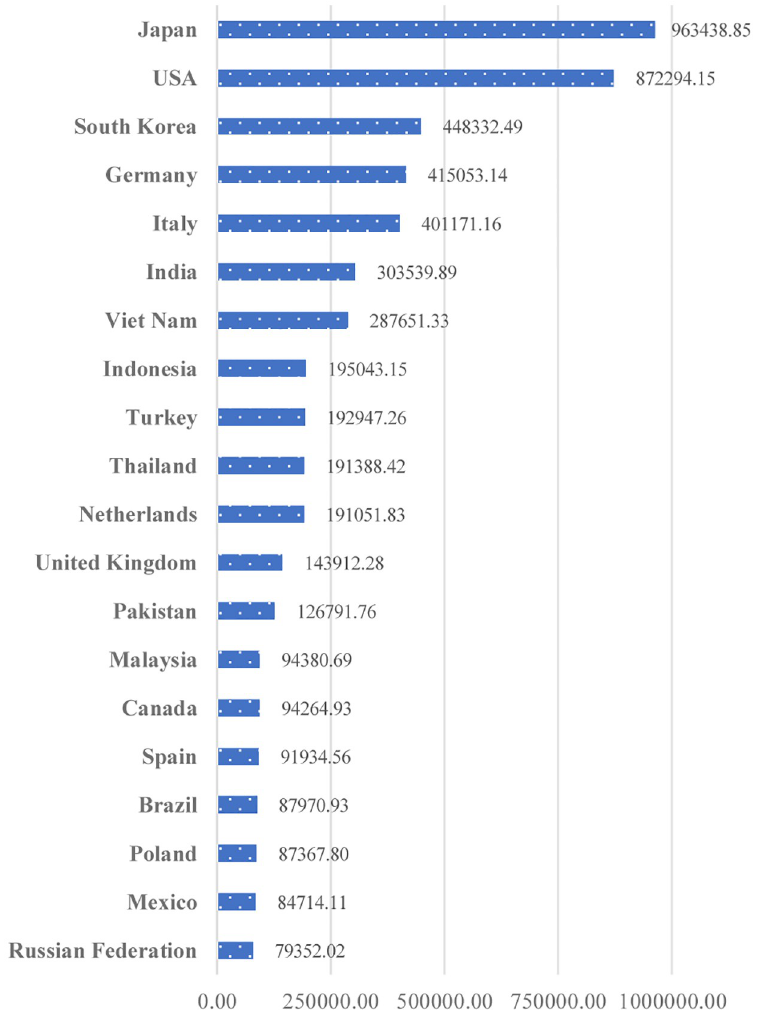
Fig 4. China’s average agricultural export flows in 1000 USD,